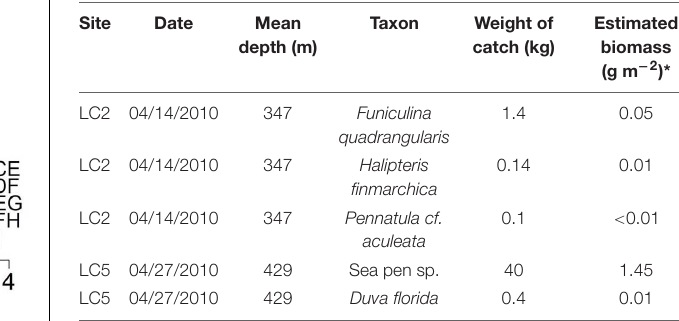
TABLE 7 | Coral biomass from Fisheries and Oceans Canada (Newfoundland and Labrador Region) multispecies surveys using a Campelen 1800 Shrimp Trawl from one trawl set at station LC2 and